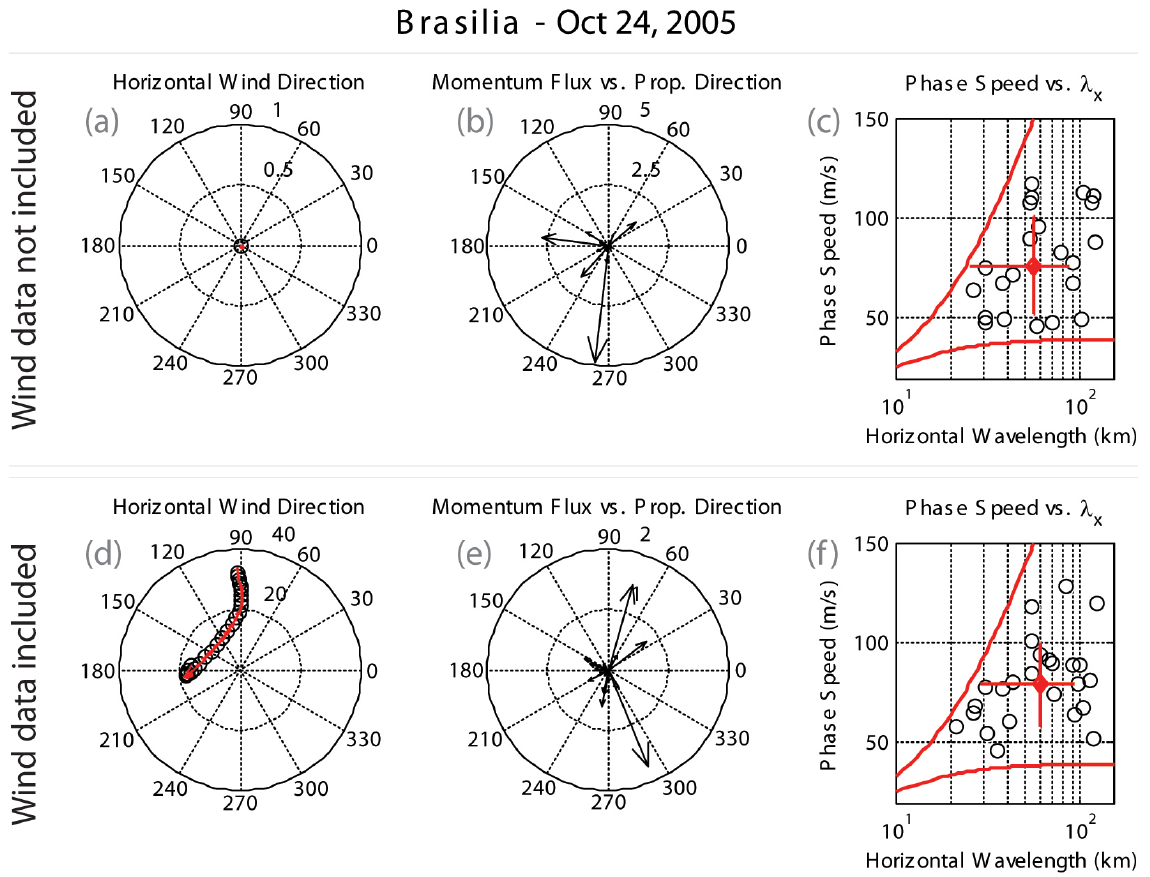
Fig. 4. Differences of wave parameters (night of 24 October, Brasilia) in two different situations: wind information is considered or not considered in the analysis procedure. Panels (a) and (d) show angular plot of wind data available for the night. Panels (b) and (e) show the angular distribution of the direction of propagation and the momentum flux magnitude of detected wave events. Panels (c) and (f) show the distribution of wave events in face to their phase velocities and horizontal wavelength. Thick red lines indicate the limits of the analysis procedure for detection of gravity